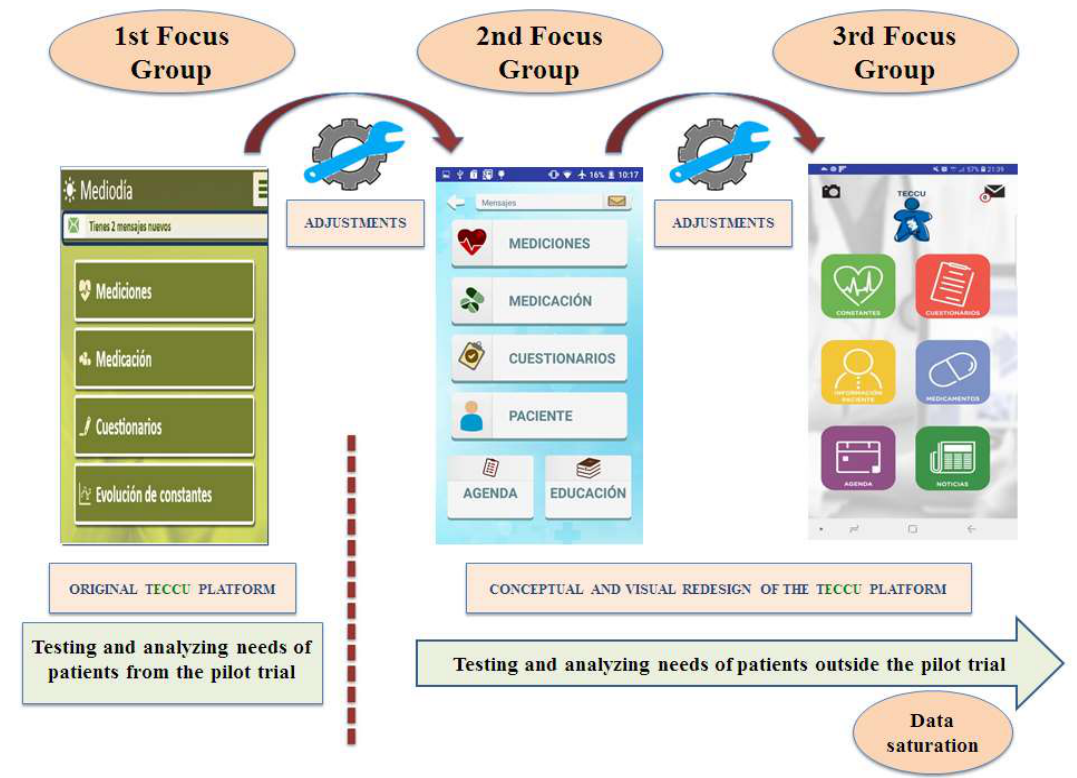
Figure 1. The workflow followed to guide the continuous adaptation of the TECCU platform.